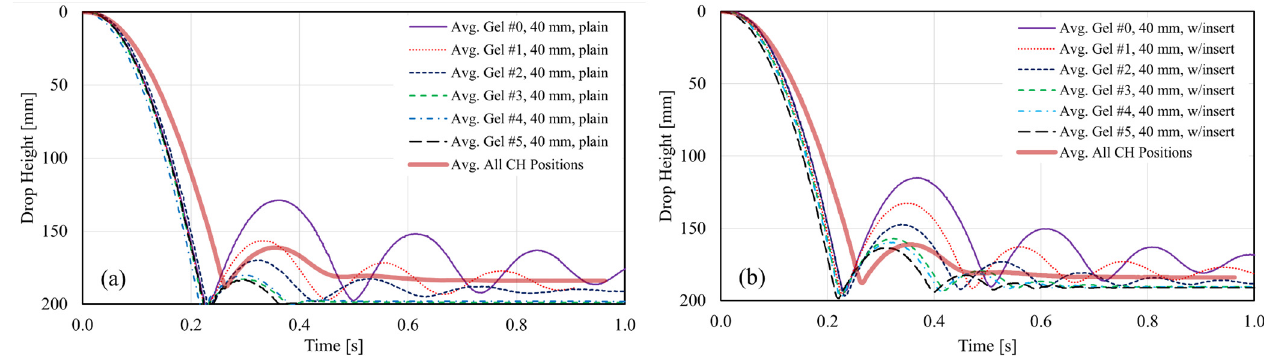
Figure 6. Comparison of average impactor trajectories for 20 mm thick gel specimens: ( a ) plain specimens; ( b ) with tubular insert.